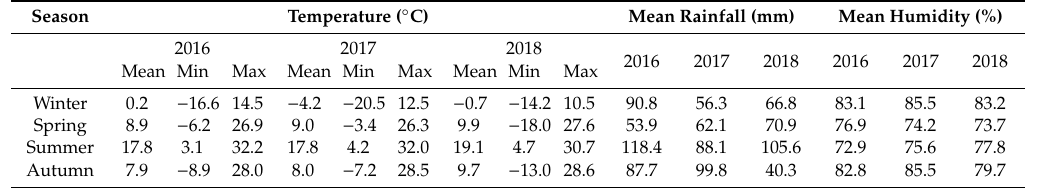
Table 2. Basic climatological parameters, mean temperature, minimum and maximum temperatures, mean rainfall, and mean humidity, during the three-year survey (2016–2018).